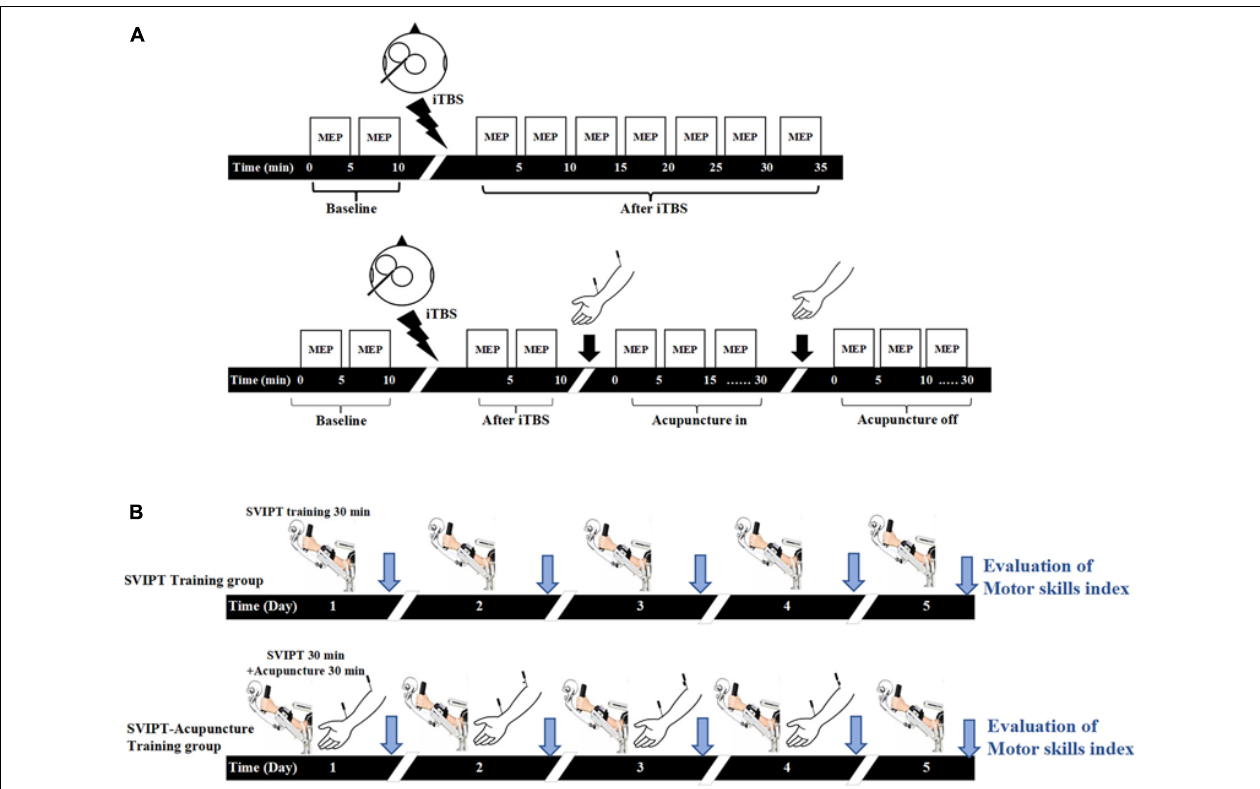
FIGURE 1 | Experimental design. (A) In the intermittent theta-burst stimulation (iTBS) group, the baseline of motor evoked potential (MEP) amplitudes induced by transcranial magnetic stimulation (TMS) with the iTBS scheme over the primary motor cortex (M1) under resting conditions was measured for 10 min, then the LTP-like plasticity induced by iTBS was measured by TMS elicited MEP for 35 min. In the iTBS-acupuncture group, the changes of MEP were tested at pre- and post-iTBS for 10 min, then measured under acupuncture-in and off for 30 min after iTBS intervention. (B) Both groups carried on sequential visual isometric pinch task (SVIPT) training for 30 min, but the SVIPT-acupuncture group was given additional acupuncture after SVIPT training. After 10 min of SVIPT intervention, two needles were inserted into the Quchi and Waiguan acupoints and kept in the upper limb of the training side for 30 min and then extracted. The learning skill index was evaluated by video recorder continuously over 5 consecutive